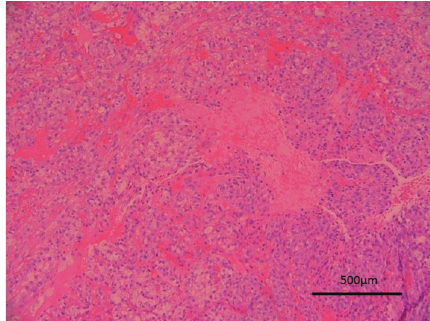
Figure2:Thishaematoxylinandeosinstainedsectionshowsgroups of cells with clear cytoplasmwith a rich associated capillary network consistent with clear cell renal